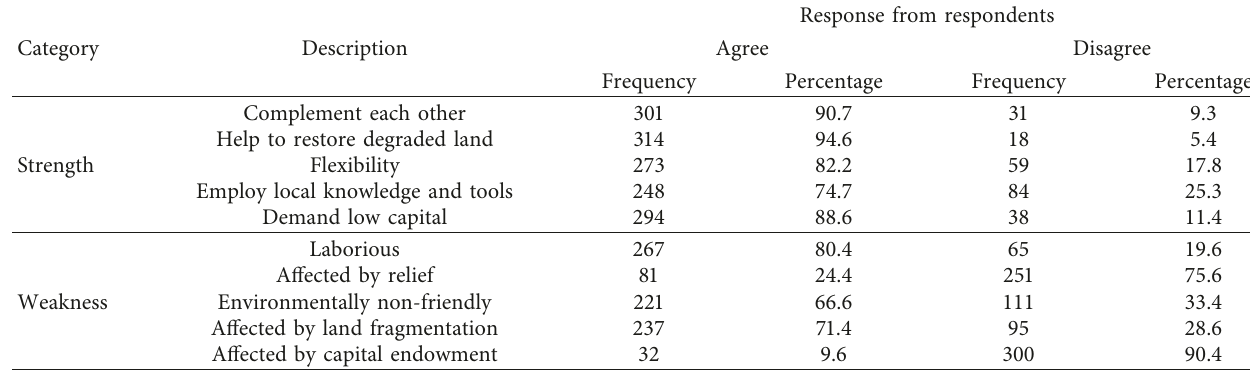
Table 4: The role of traditional soil and water conservation practices.